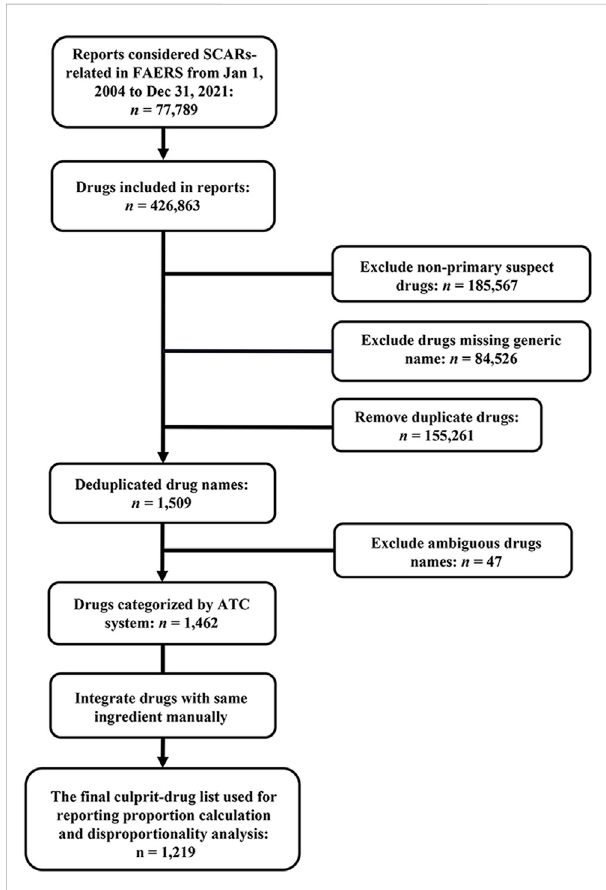
FIGURE 2 Flowchart for data acquisition and processing. ATC, Anatomical Therapeutic Chemical; FAERS, FDA Adverse Event Reporting System; SCARs, severe cutaneous adverse